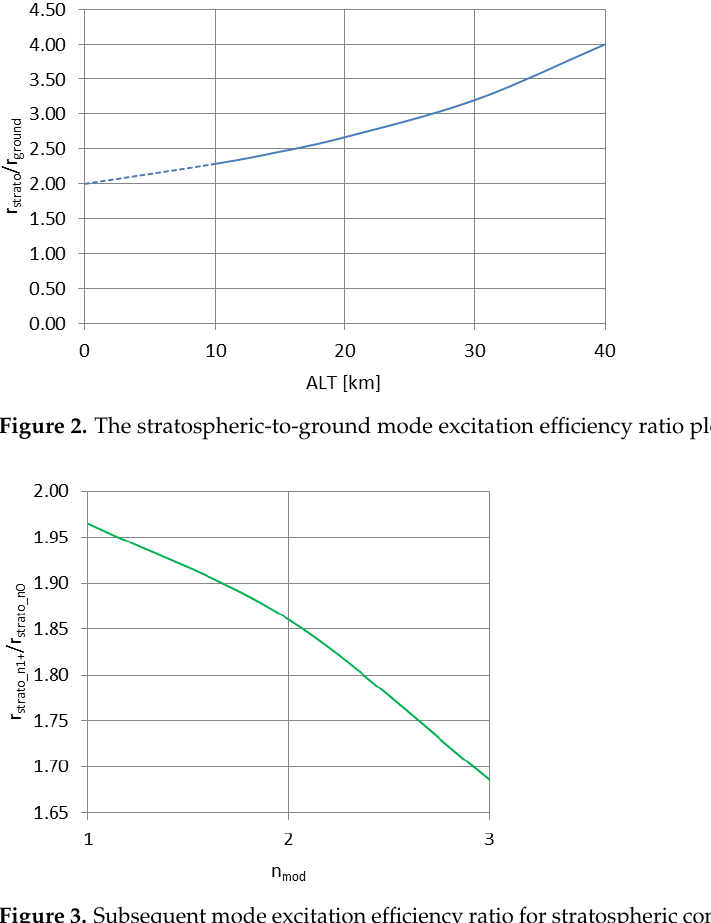
Figure 3. Subsequent mode excitation efficiency ratio for stratospheric conditions plotted for different altitudes.